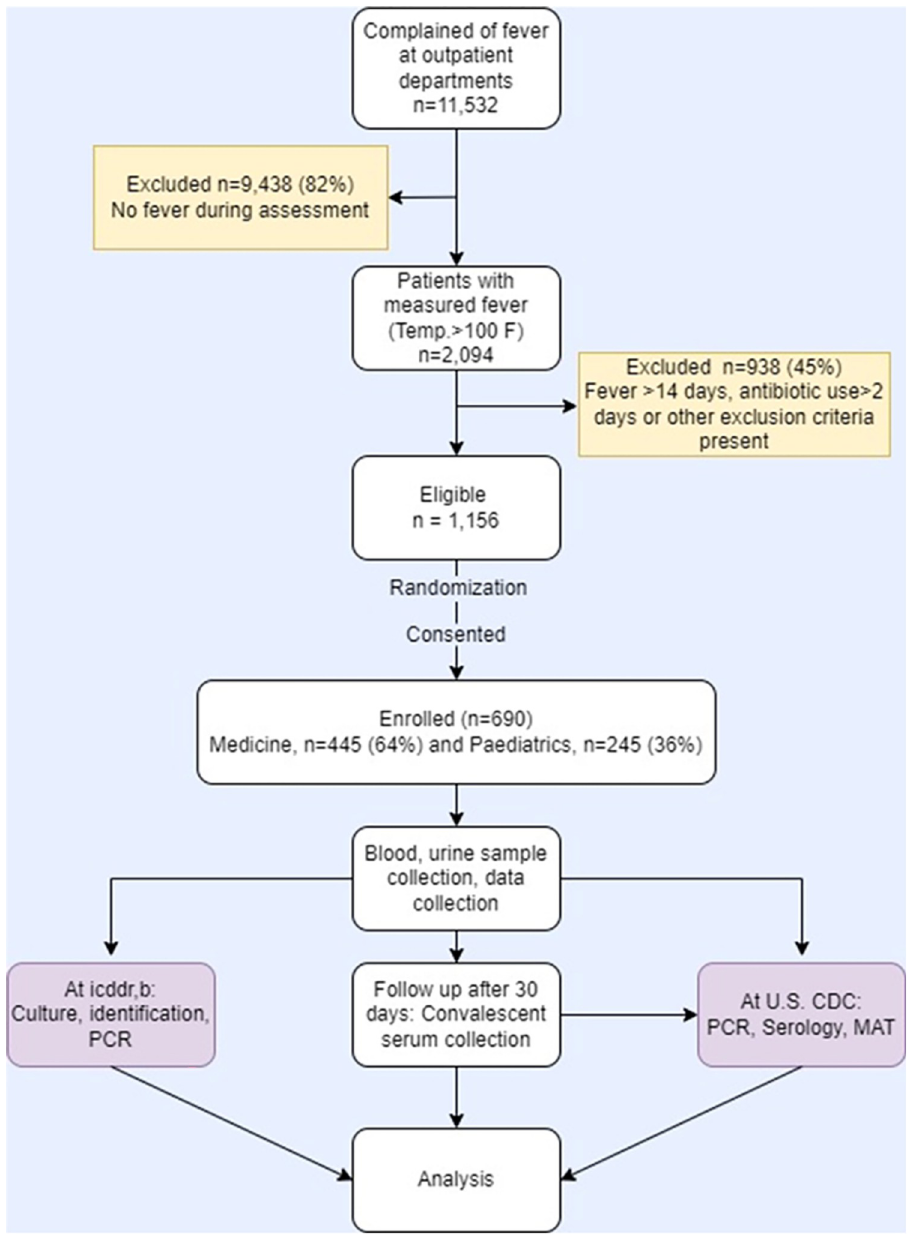
Fig 2. Flow diagram of surveillance enrollments among adults and children who visited outpatient departments for acute febrile illness (AFI) in Bangladesh, May 2019-March 2020.